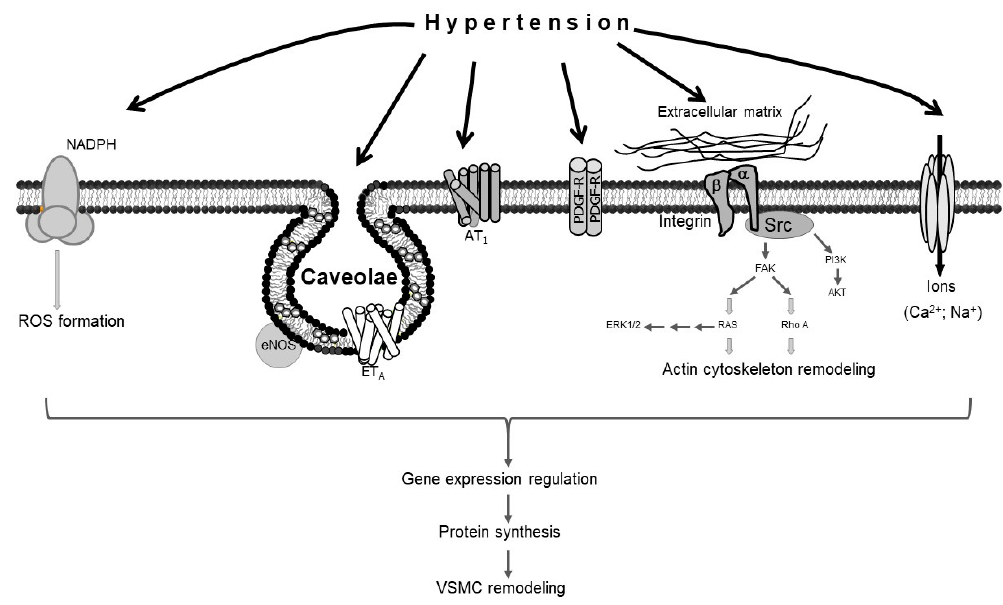
Figure 1. Schematic representation of vascular smooth muscle cell (VSMC) remodeling in response to hypertension. Hypertension stimulates different sensors in the plasma membrane of VSMCs, activating several signaling pathways that lead to VSMC remodeling.